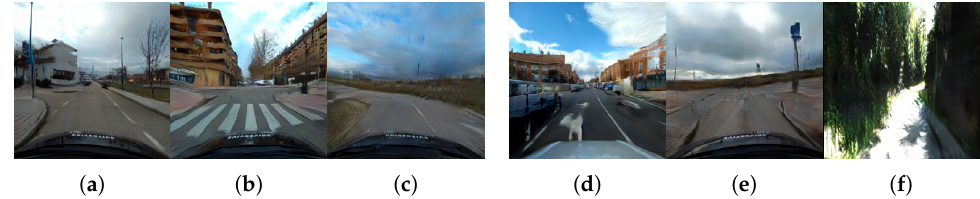
Figure 14. Some examples of good generated RGB intersections, included in the new augmented dataset ( a – c ), and discarded ones ( d – f